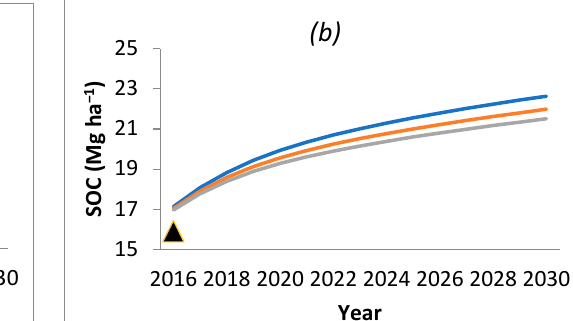
Figure 3. CO 2 evolution under a usual scenario in ( a ) Bambusa species and ( b ) Dendrocalamus species. Table 2. Statistics describing performance of model for each treatment.